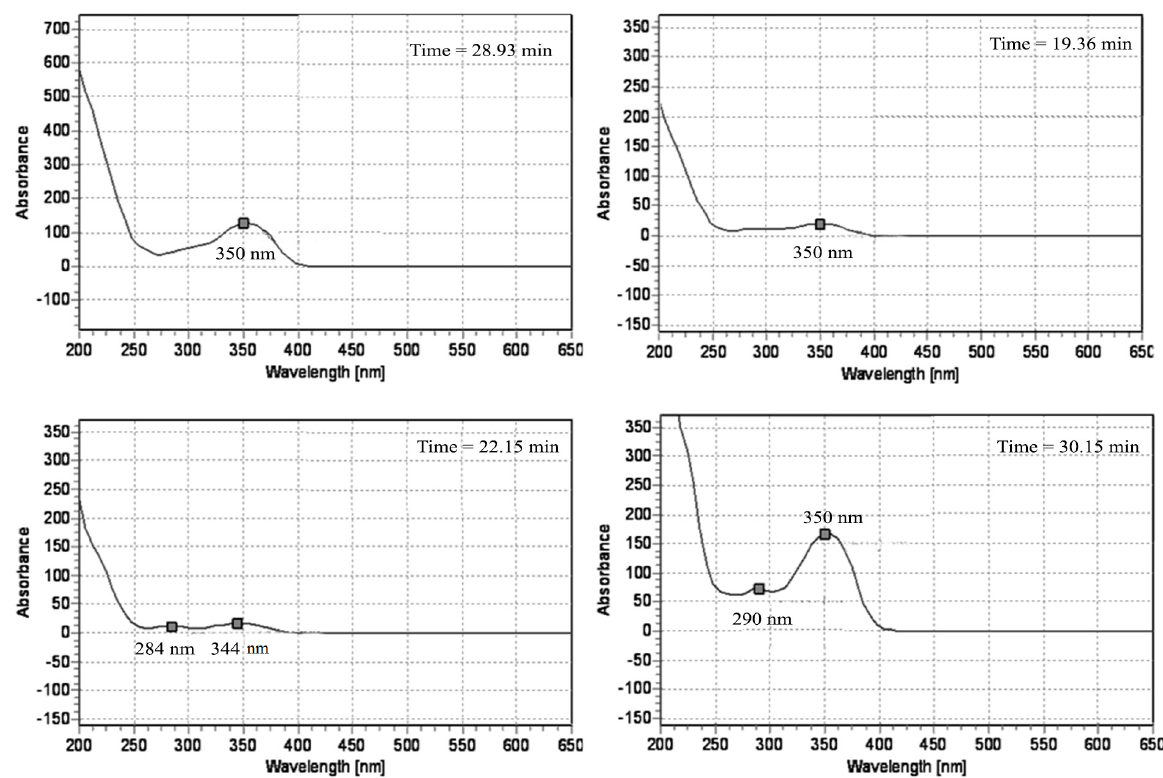
Figure 4 - Spectra in the UV-Vis region obtained by HPlC-PAD of the hydroethanolic extract from seeds of H. courbaril